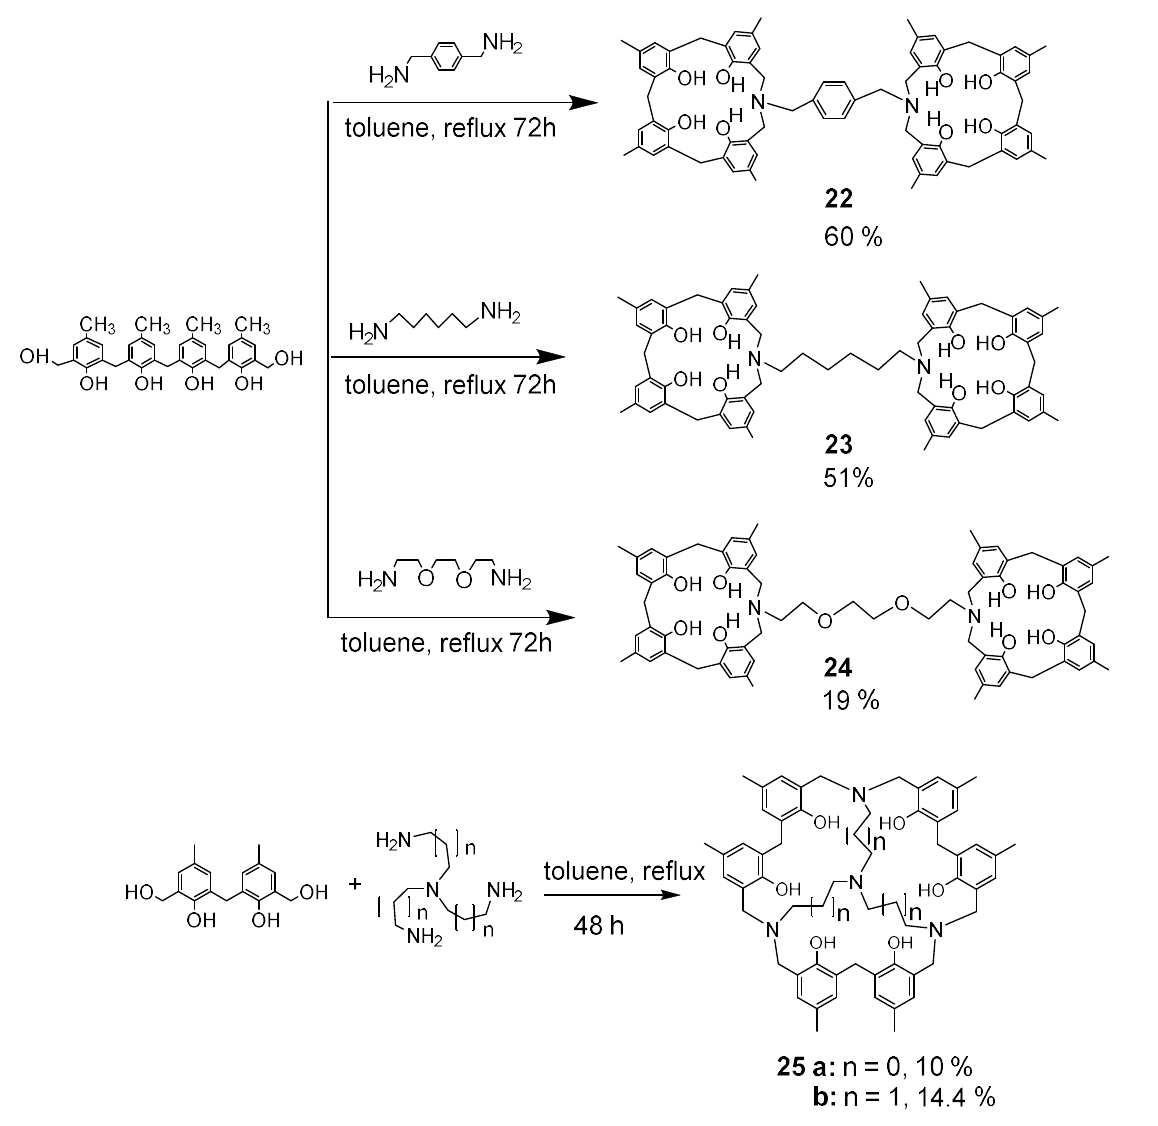
Scheme 8. Synthesis of bridged azacalixarenes.